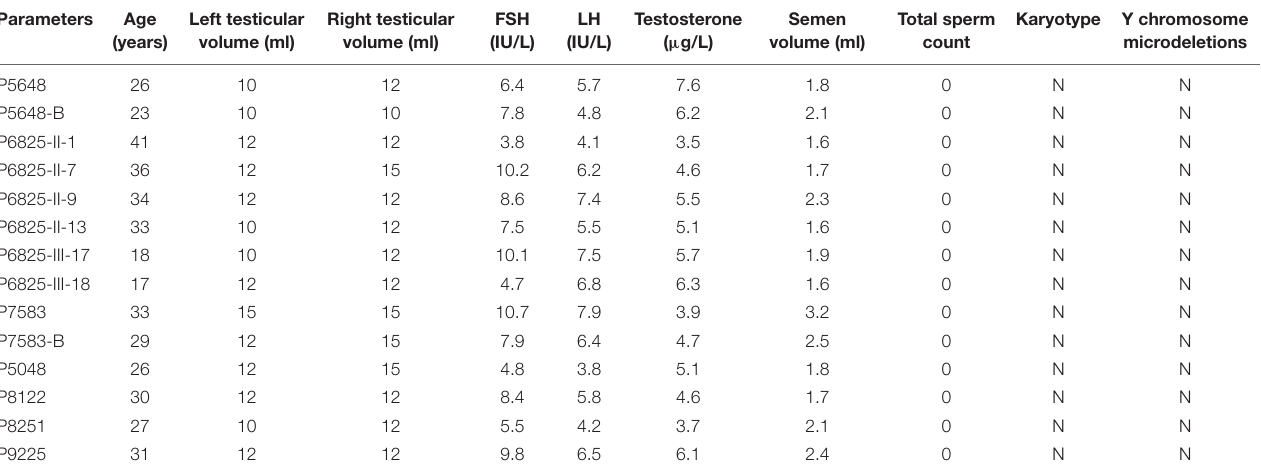
TABLE 1 | Clinical characteristics of the Chinese study subjects at the clinical assessment.